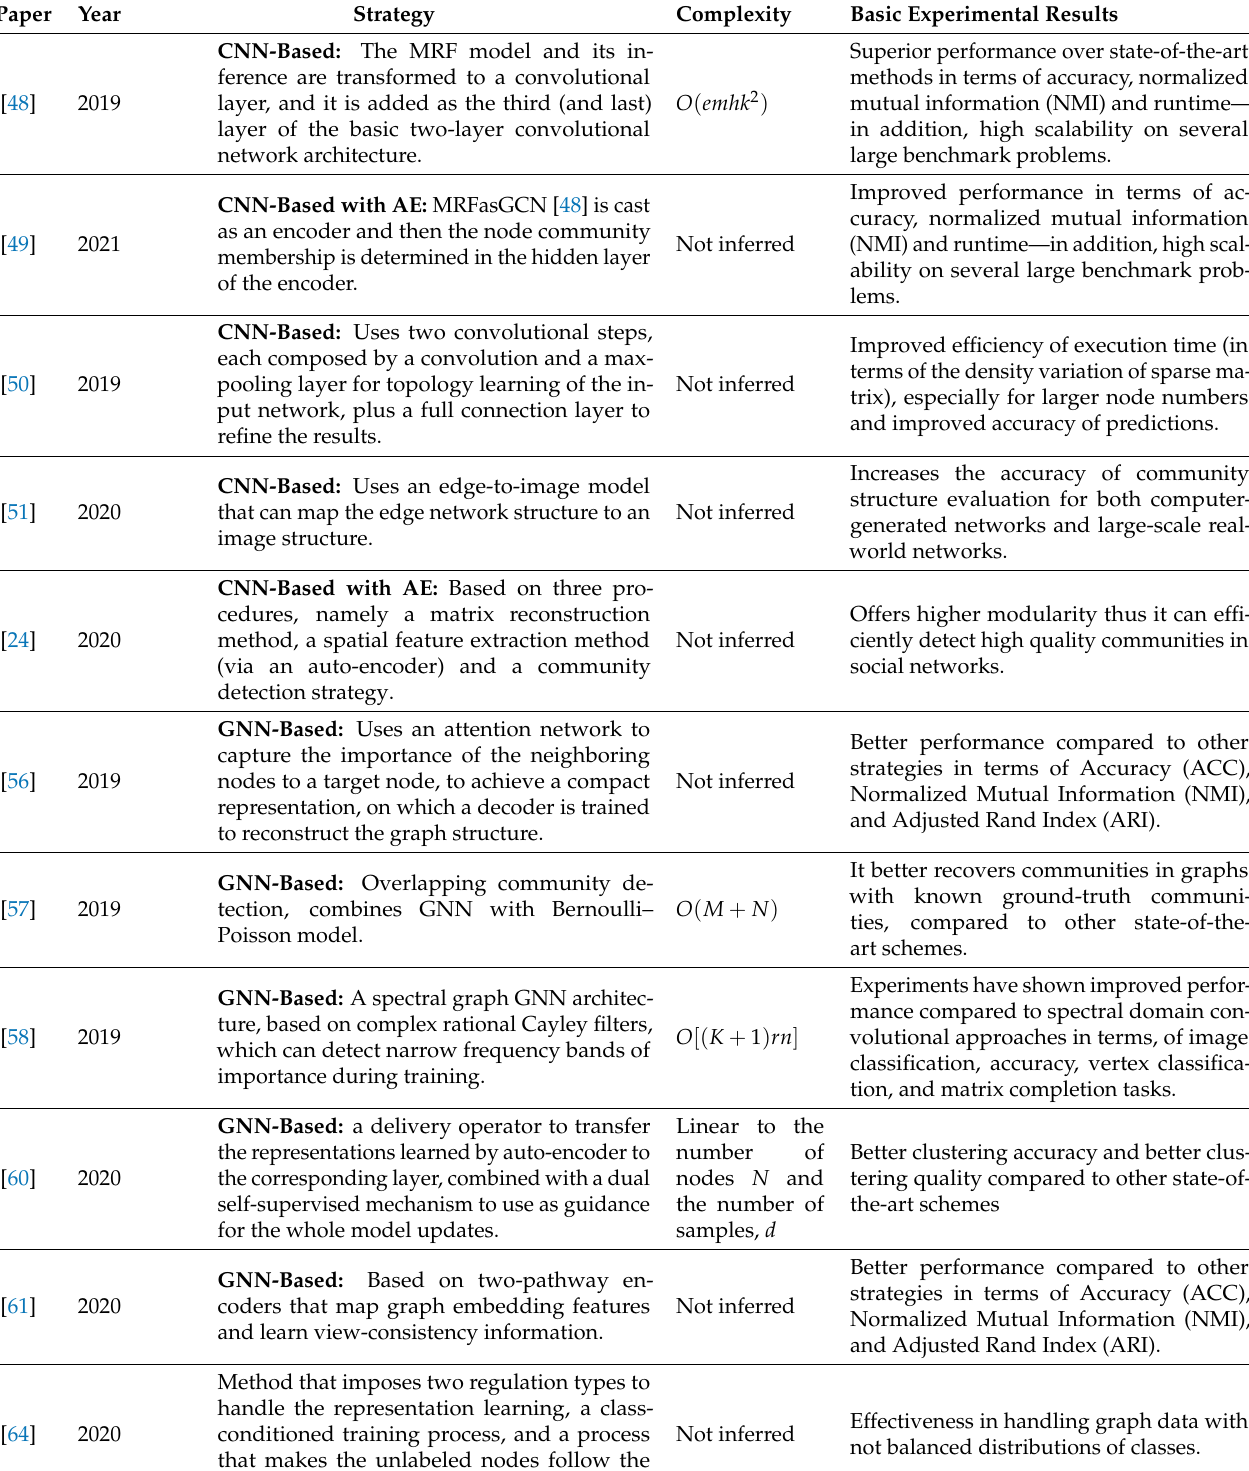
Table 2. CNN/GNN based community detection